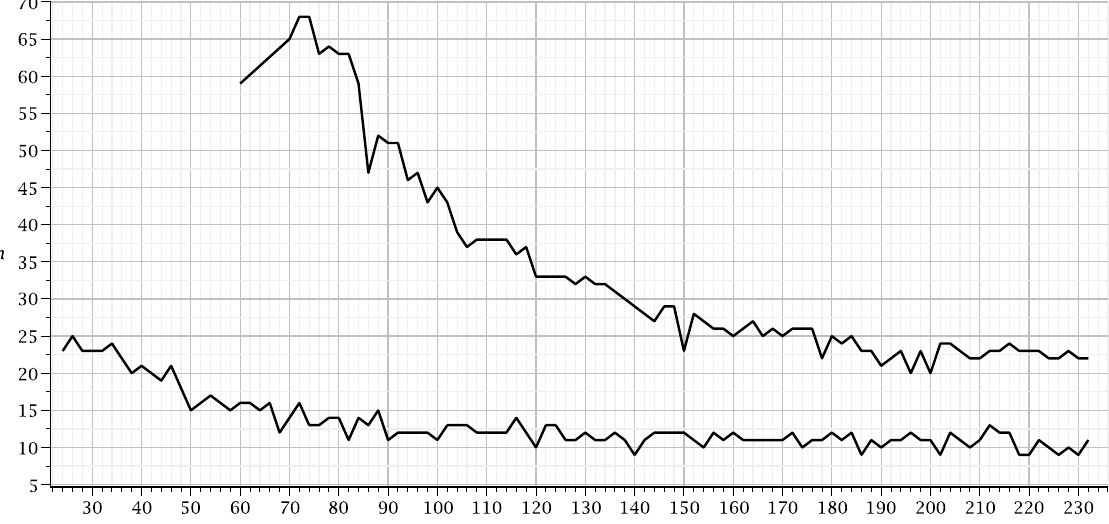
Figure 2. Difference g n between order and the maximal Wiener complexity of fullerene graphs (bottom line) and IPR fullerene graphs (top line) of order n ≤